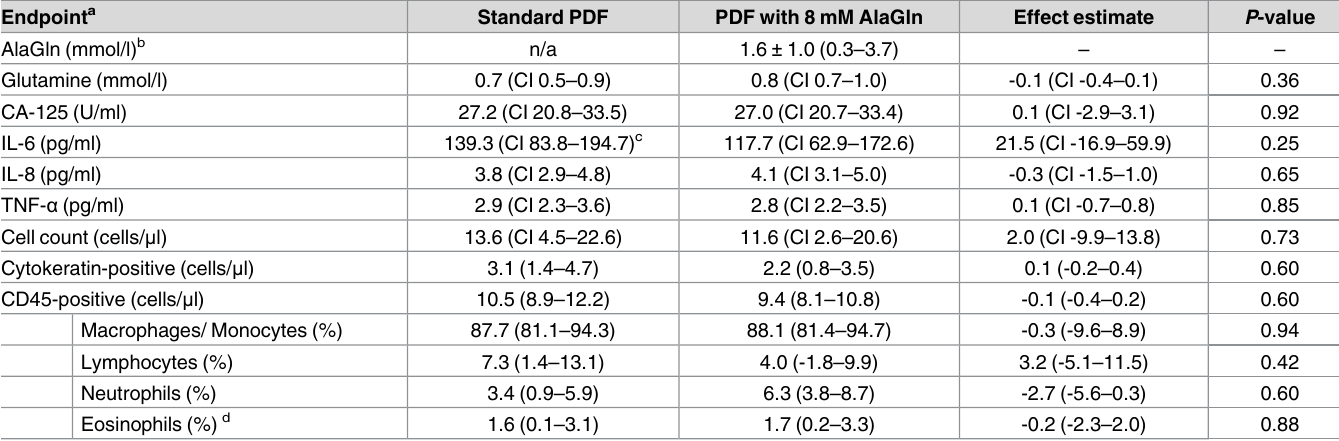
Table 4. Secondary outcome parameters in dialysate effluent at 4 hours.